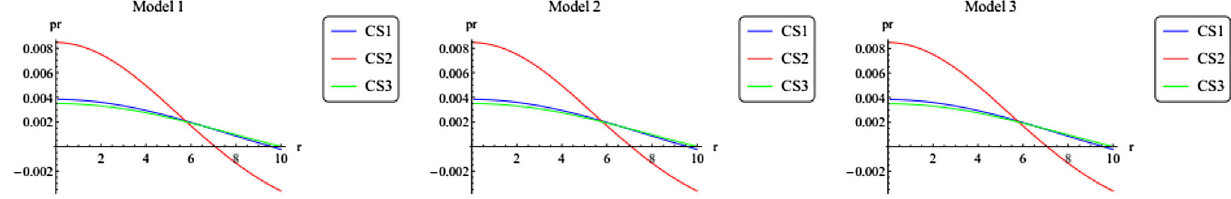
Fig. 2 Evolution of radial pressure for charged stars, Vela X-1, SAX J 1808.4-3658, and 4U 1820-30, under different viable f ( G ) models